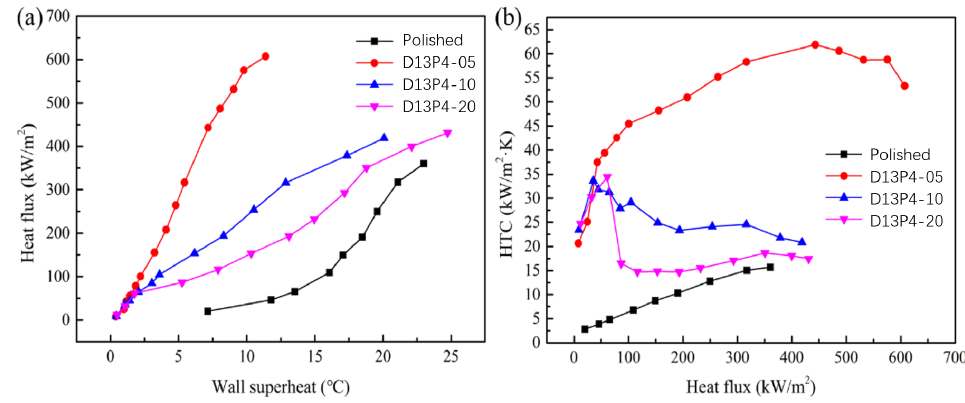
Figure 8. Different thickness of aluminum powder sintered porous wick: ( a ) boiling curve, ( b ) boiling heat transfer coefficient.